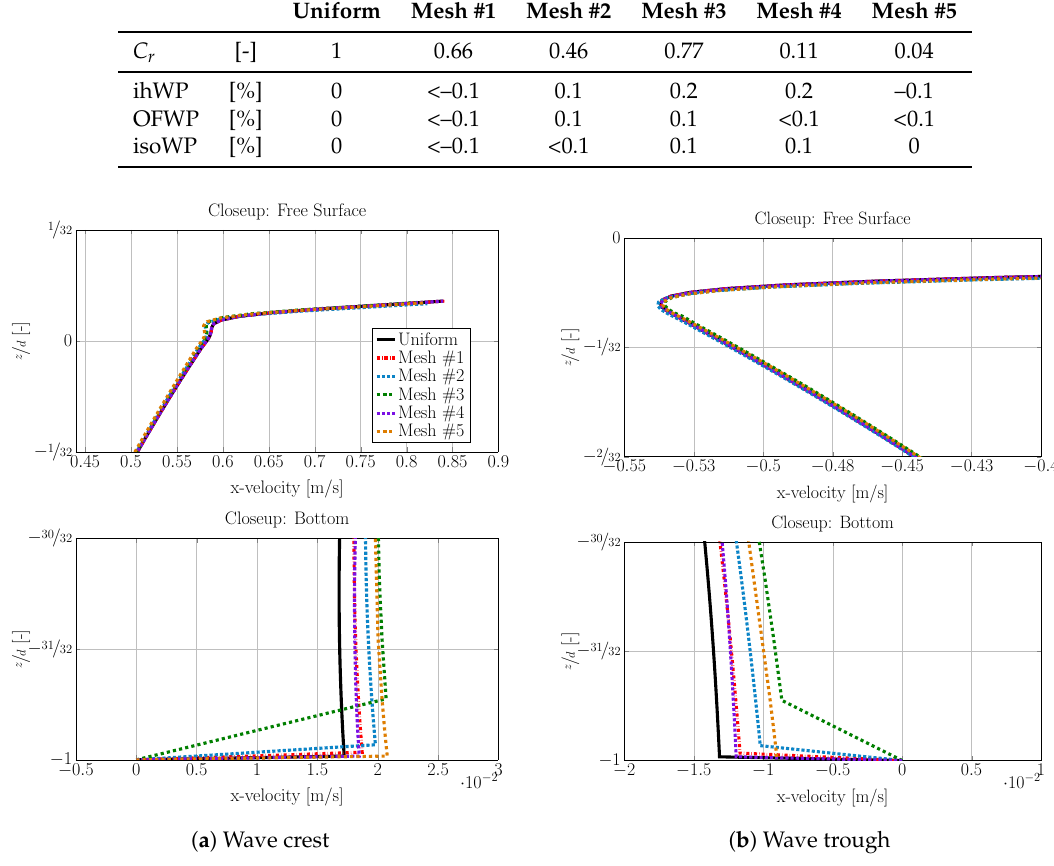
Figure 11. Velocity profiles extracted along the tank depth for the wave crest ( a ) and trough ( b ) for different meshes using varying refinement layers along the water column according to Figure